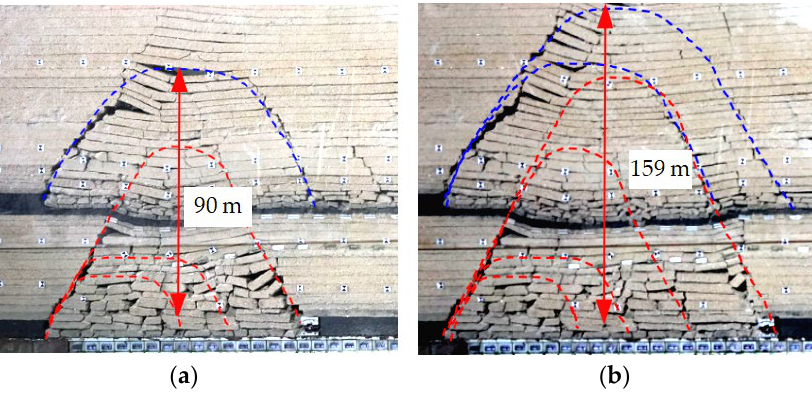
Figure 8. Law of weighting during interburden broken: ( a ) SPW2. ( b ) TPW3.